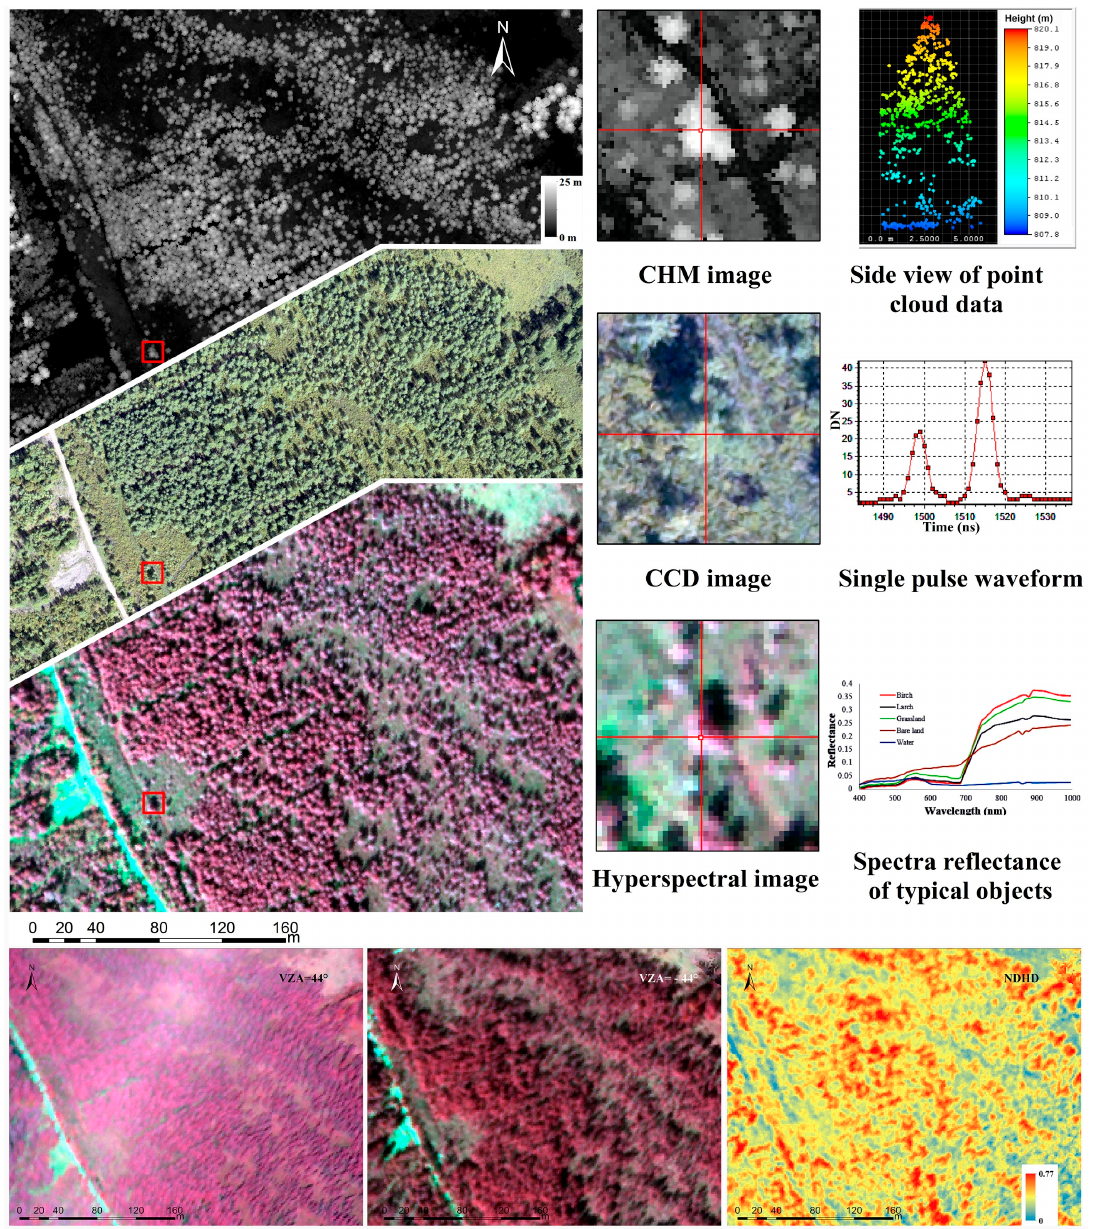
Figure 7. Coincident acquisition of LiDAR, CCD, and multi-angle hyperspectral data with LiCHy system in a temperate forest (29 August 2015; 50.931 ˝ N, 121.503 ˝ E). The top images in the left column are Canopy Height Model (CHM) from LiDAR data, CCD image and hyperspectral image of the same ground target. The middle column shows the enlarged view of the left pictures. The right column shows the side view of point cloud data from single tree, waveform of a single laser pulse and the spectrum of typical targets from hyperspectral data. The bottom images are multi-angle hyperspectral data for viewing zenith angle (VZA) of ˘ 44 ˝ , and the derived Normalized Difference between Hotspot and Darkspot (NDHD) map using band of 849.30 nm. The spatial resolutions of CHM data, CCD data and hyperspectral data (VZA = 0 ˝ ) are 0.5 m, 0.8 m and 0.2 m, respectively. The central wavelengths of displayed hyperspectral image for red, green and blue bands are 849.30, 694.91 and 543.72